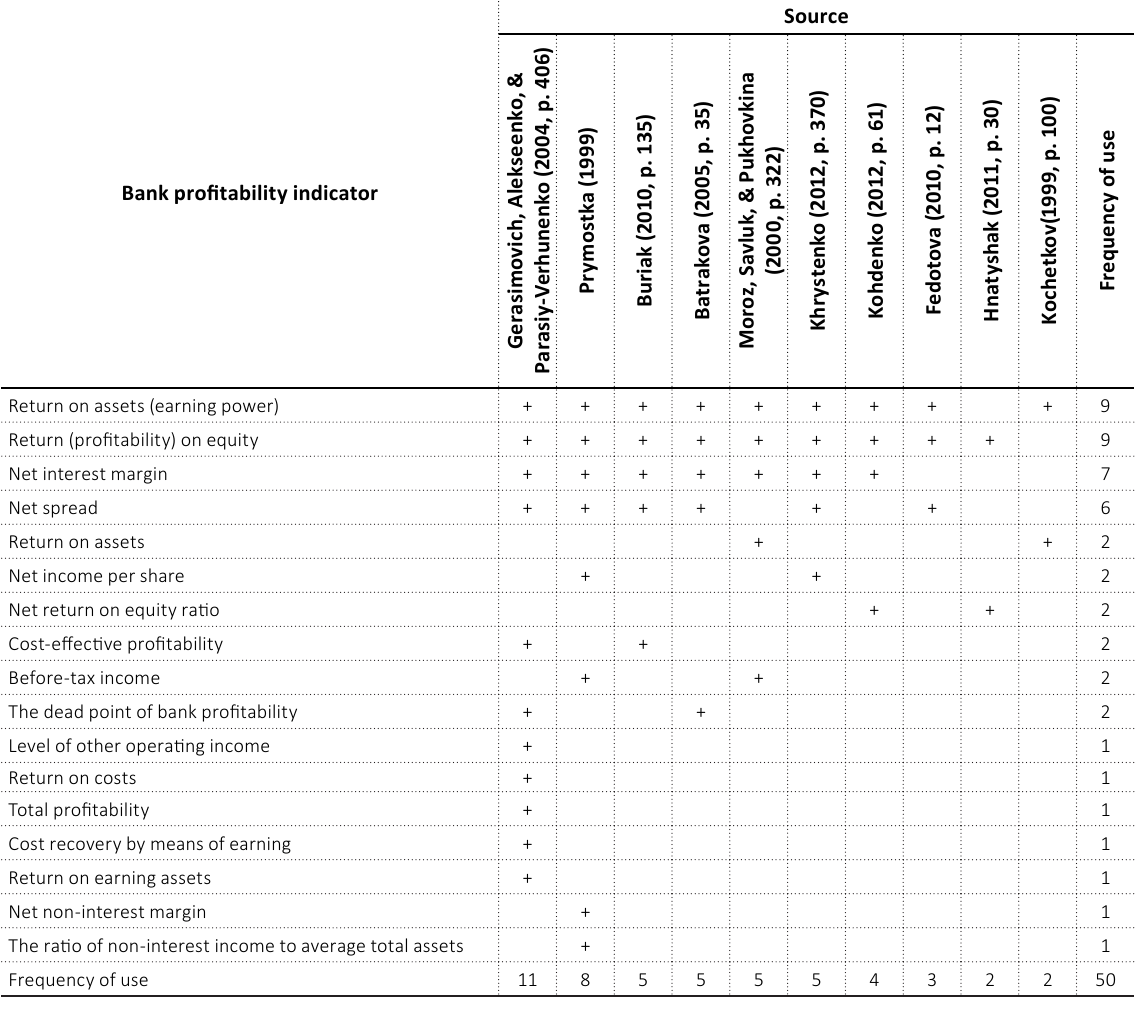
Bank profitability